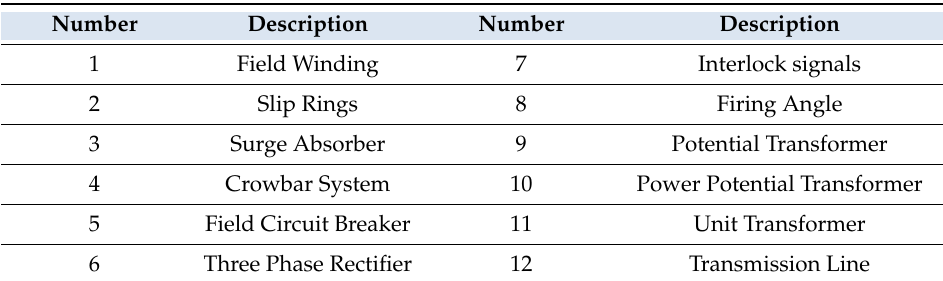
Figure 3. The sample power generation system developed by using the phase domain (PD) model for thorough LOE studies. Table 1. Definitions of the studied system